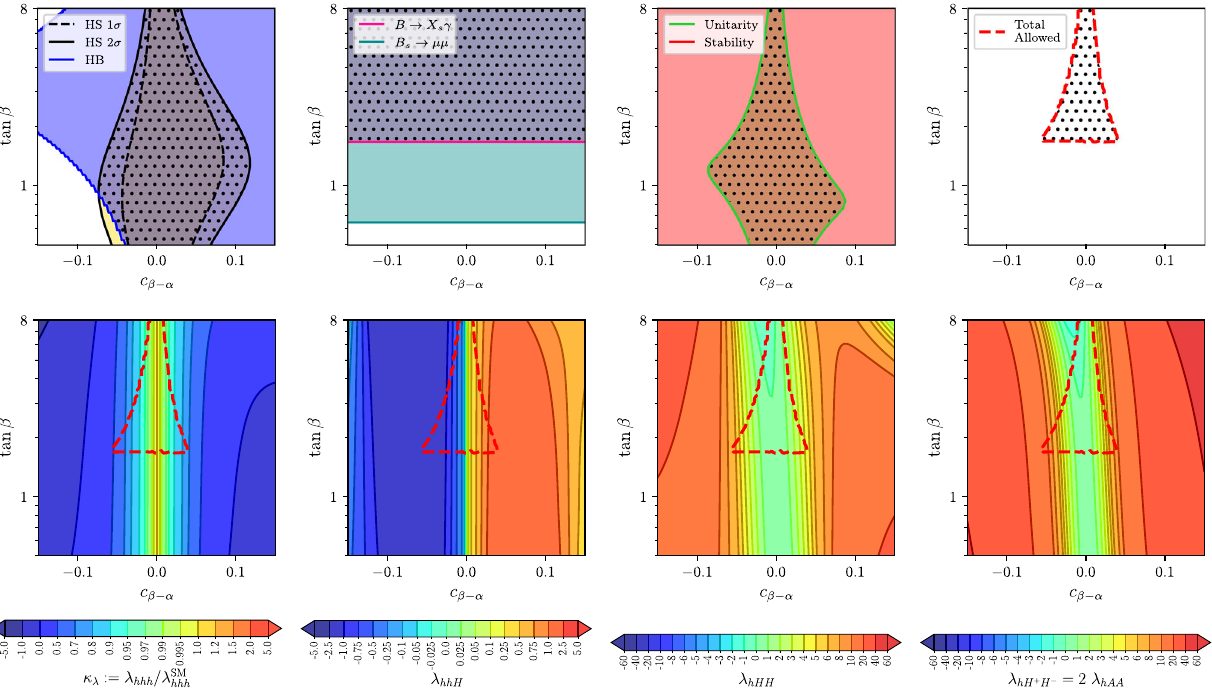
Fig. 13 Allowed areas (dotted regions) from the various constraints (upper row) and triple Higgs couplings (lower row) for the benchmark scenario IV-2 in the c β − α –tan β plane with m ≡ m H = m A = m H ± = 1300 GeV and m 2